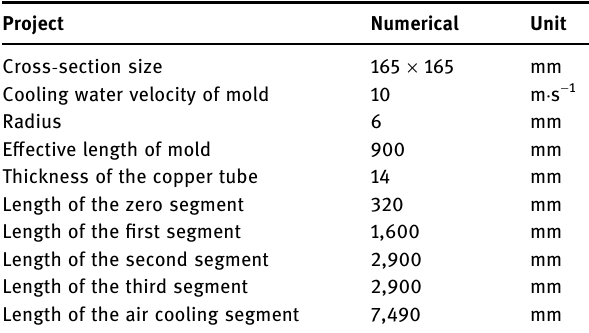
Table 1: Typical continuous casting process parameters